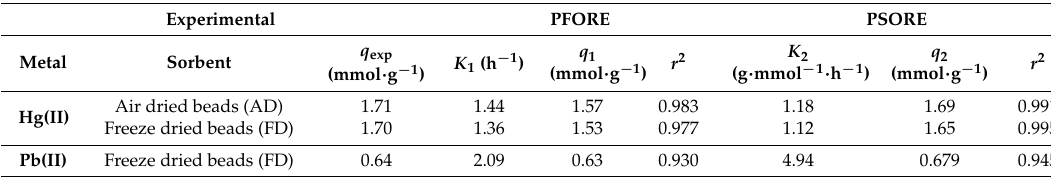
Table 3. Kinetic parameters of sorbent materials.